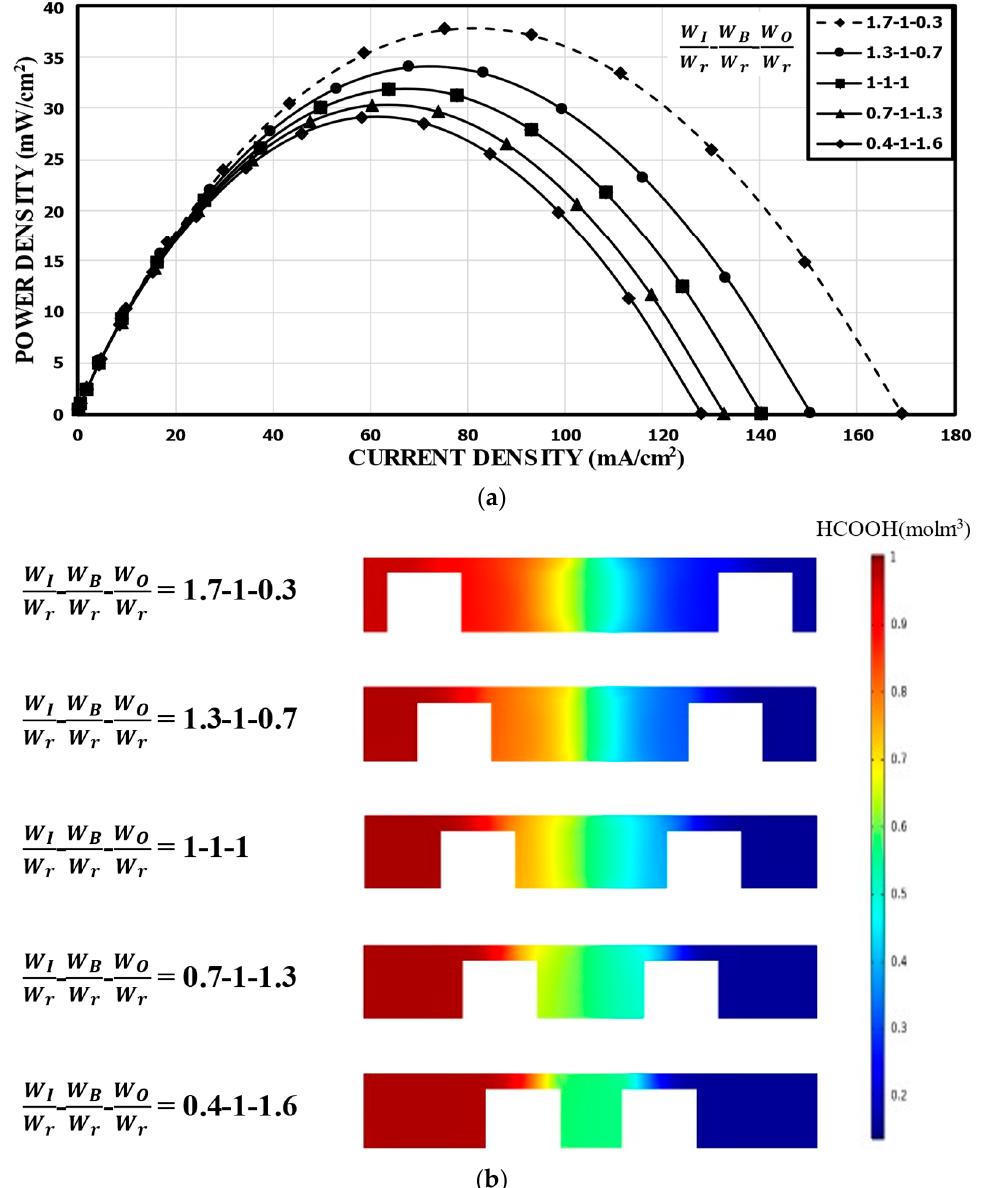
Figure 7. Power density curves for fixed W B : ( a ) performance curves; ( b ) concentration contours of fuel (HCOOH) at the xz plane, 5 mm from the channel